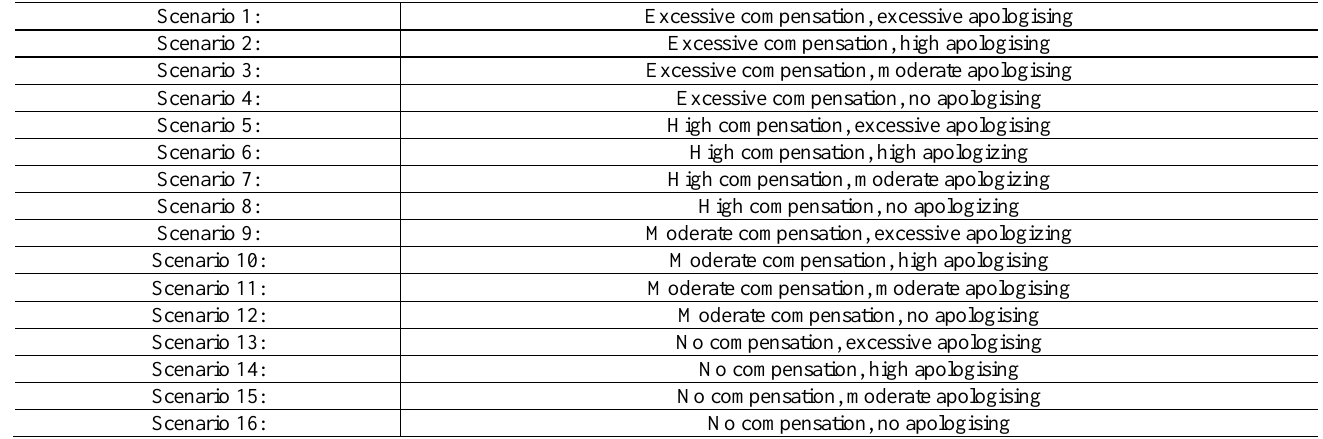
Table 1: Scenario